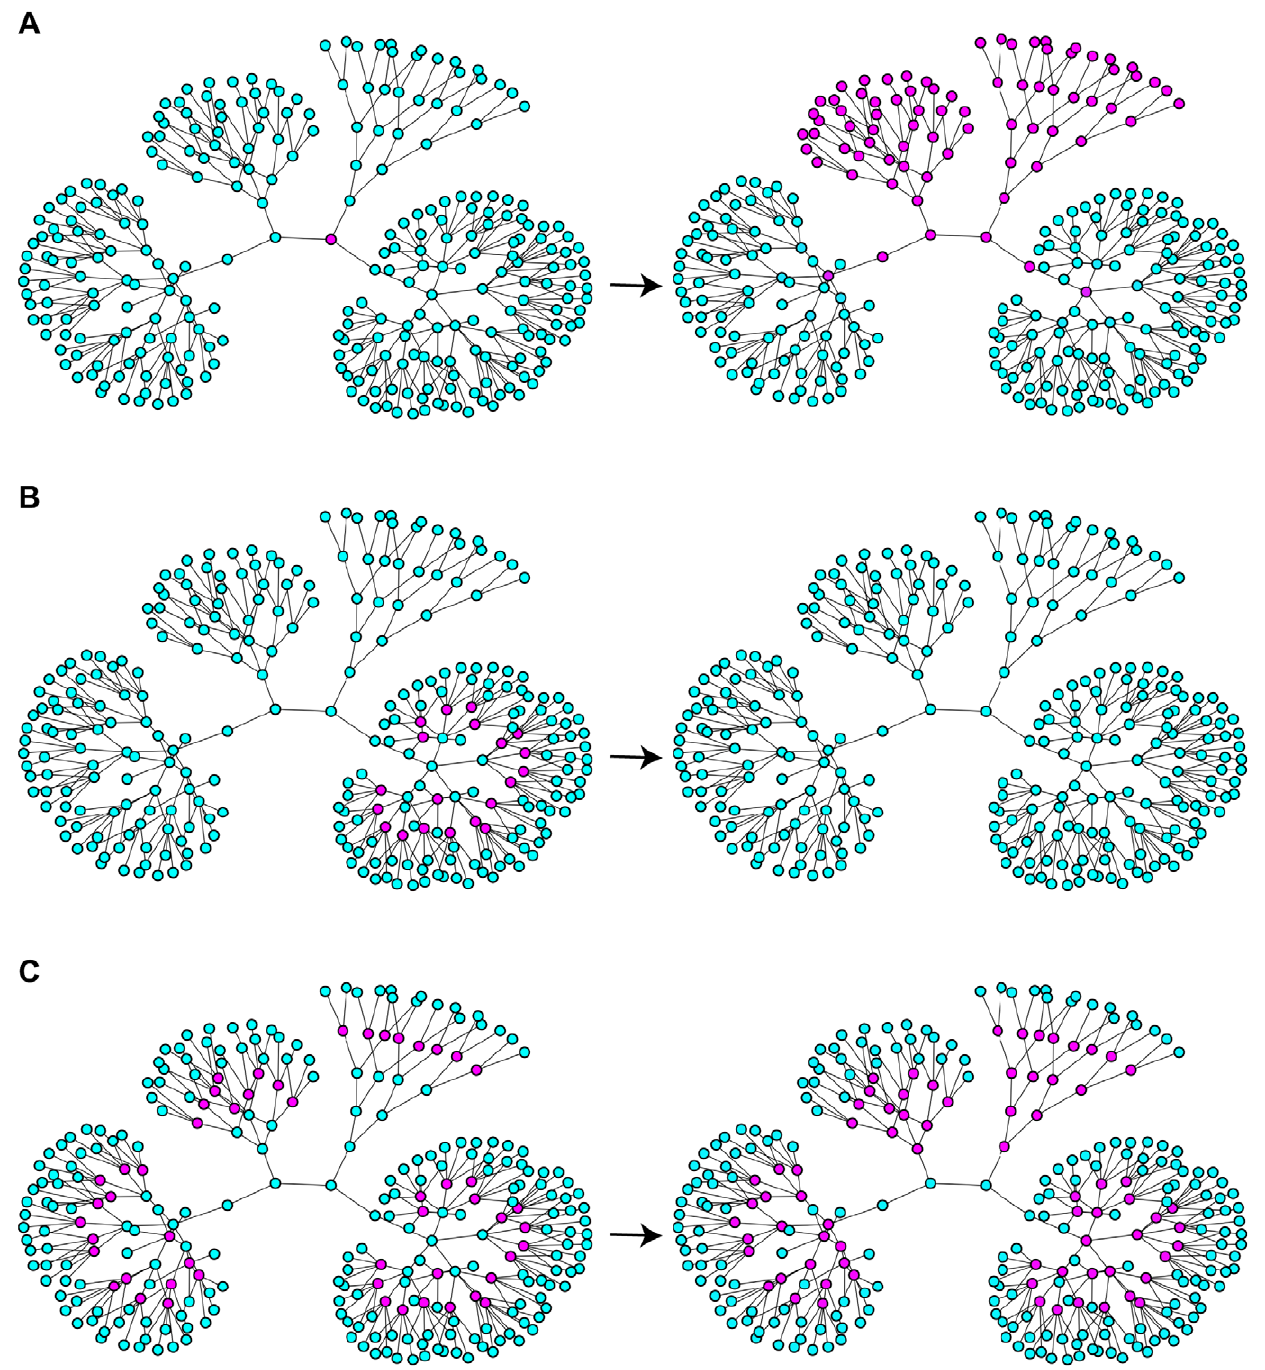
Figure 4. Spreading, retreating and pinning of activation fronts in trees. A) For D ~ 0 : 1 , the fronts spread to the periphery through the nodes with the degrees k ~ 2,3,4 , while they are pinned at the nodes with the larger degrees. B) For D ~ 0 : 35 , the front is retreated from nodes with degree k ~ 6 . C) For D ~ 0 : 03 , the fronts propagate towards the root, but not towards the periphery. In each row, the initial configuration (left) and the final stationary pattern (right) are displayed. The same color coding for node activity as in Fig. 2 is used. Other parameters are r 1 ~ 1 , r 2 ~ 1 : 4 and r 3 ~ 3 .